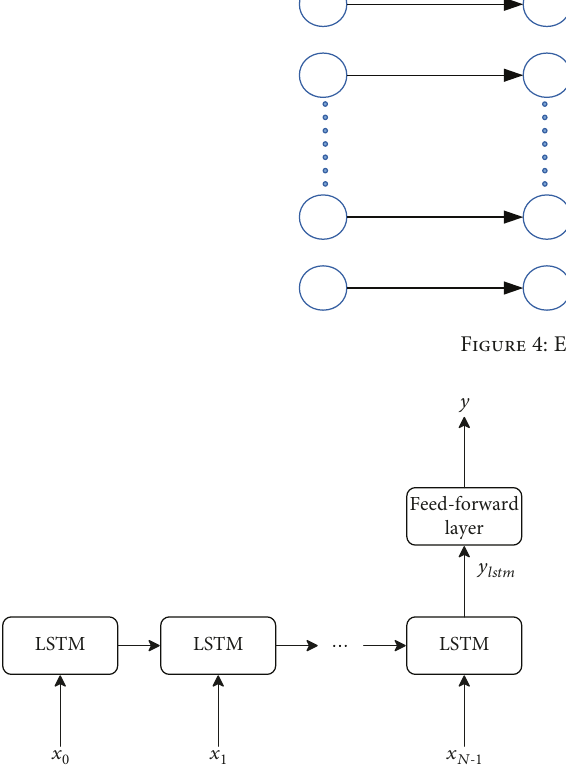
Figure 5: LSTM unfolded into a full